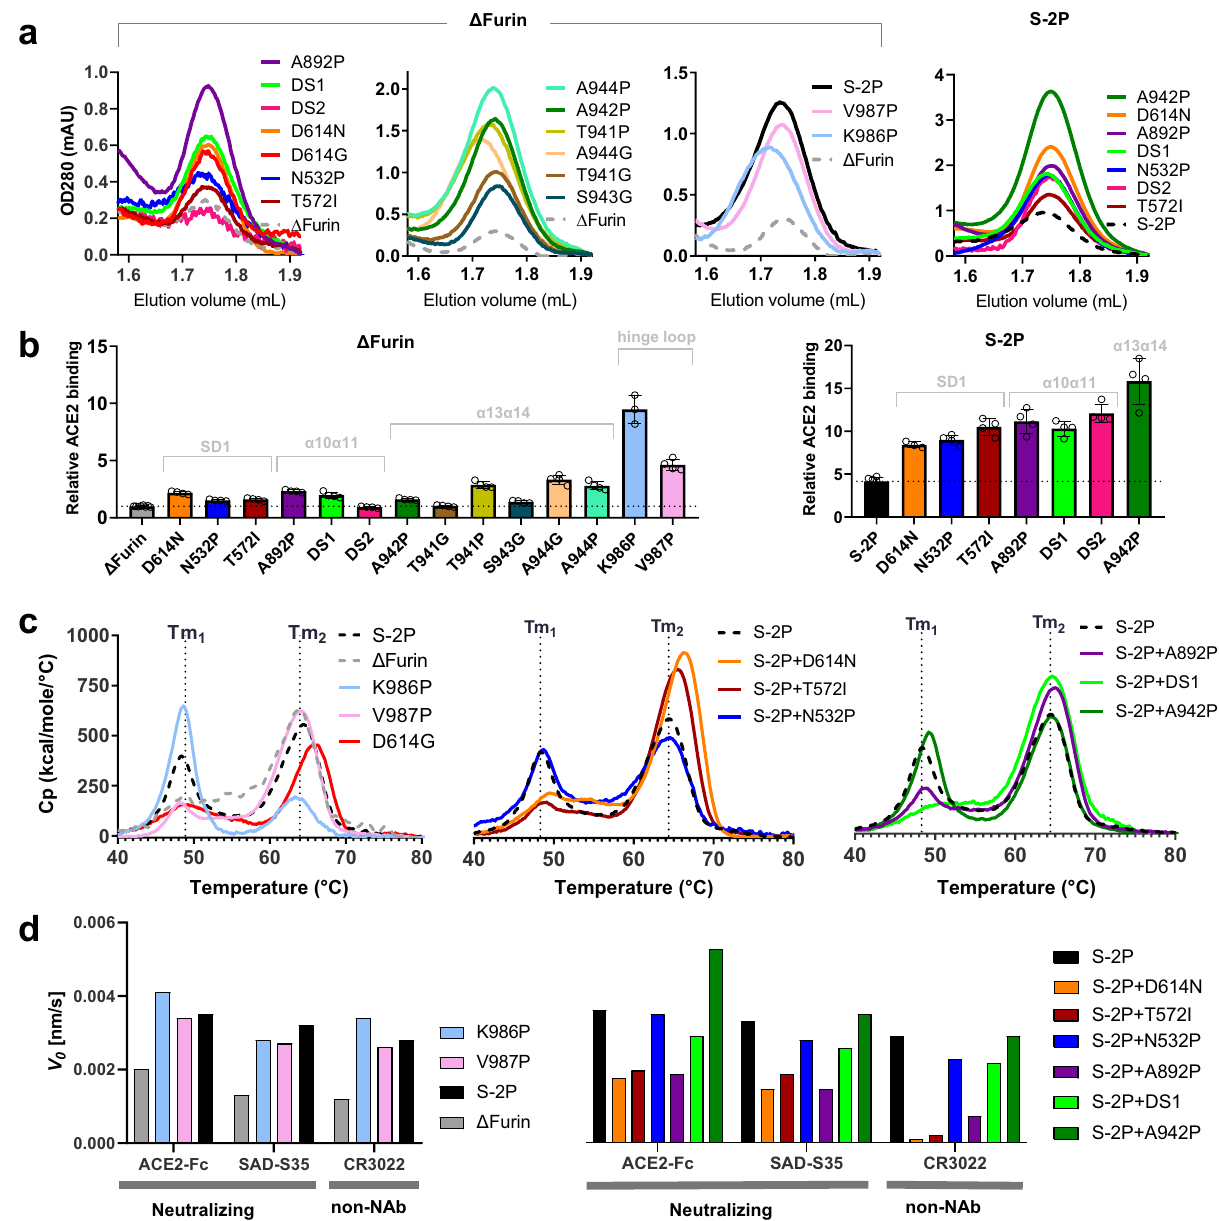
Fig. 1 Characterization of SARS-CoV-2 S mutants containing single stabilizing mutations. a Analytical SEC of S variants on an SRT-10C SEC-500 15 cm column showing the trimer peak (solid line) relative to the control, which is the un-mutated backbone (dashed line). b ACE2-Fc binding to S protein mutants based on AlphaLISA of Δ Furin variants (left panel) and S-2P (right panel). Data are represented as mean + SD of n = 4 biologically independent samples in one experiment. Mutants were grouped according to the structural regions indicated in light gray. c Temperature stability of puri fi ed S trimers as measured by DSC. Two melting events are indicated by Tm1 and Tm2. c (left panel) Uncleaved SARS2-S variants with furin site mutations ( Δ Furin), with one stabilizing proline mutation in the hinge loop ( Δ Furin K986P or Δ Furin V987P), and both proline mutations in the hinge loop (S-2P); (middle panel) Δ Furin variants with indicated mutations in S1 and (right panel) Δ Furin variants with indicated mutations in S2. d Binding of SAD-S35, ACE2, and CR3022 to puri fi ed S proteins measured with BioLayer Interferometry, showing the initial slope V 0 at the start of binding. Source data are provided as a Source Data fi